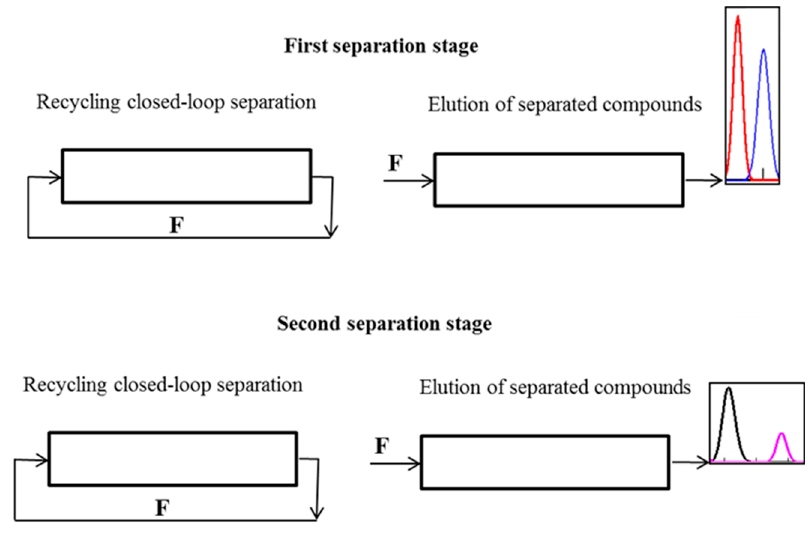
Figure 5. Two-stage CLR CCC separation of complex mixtures.